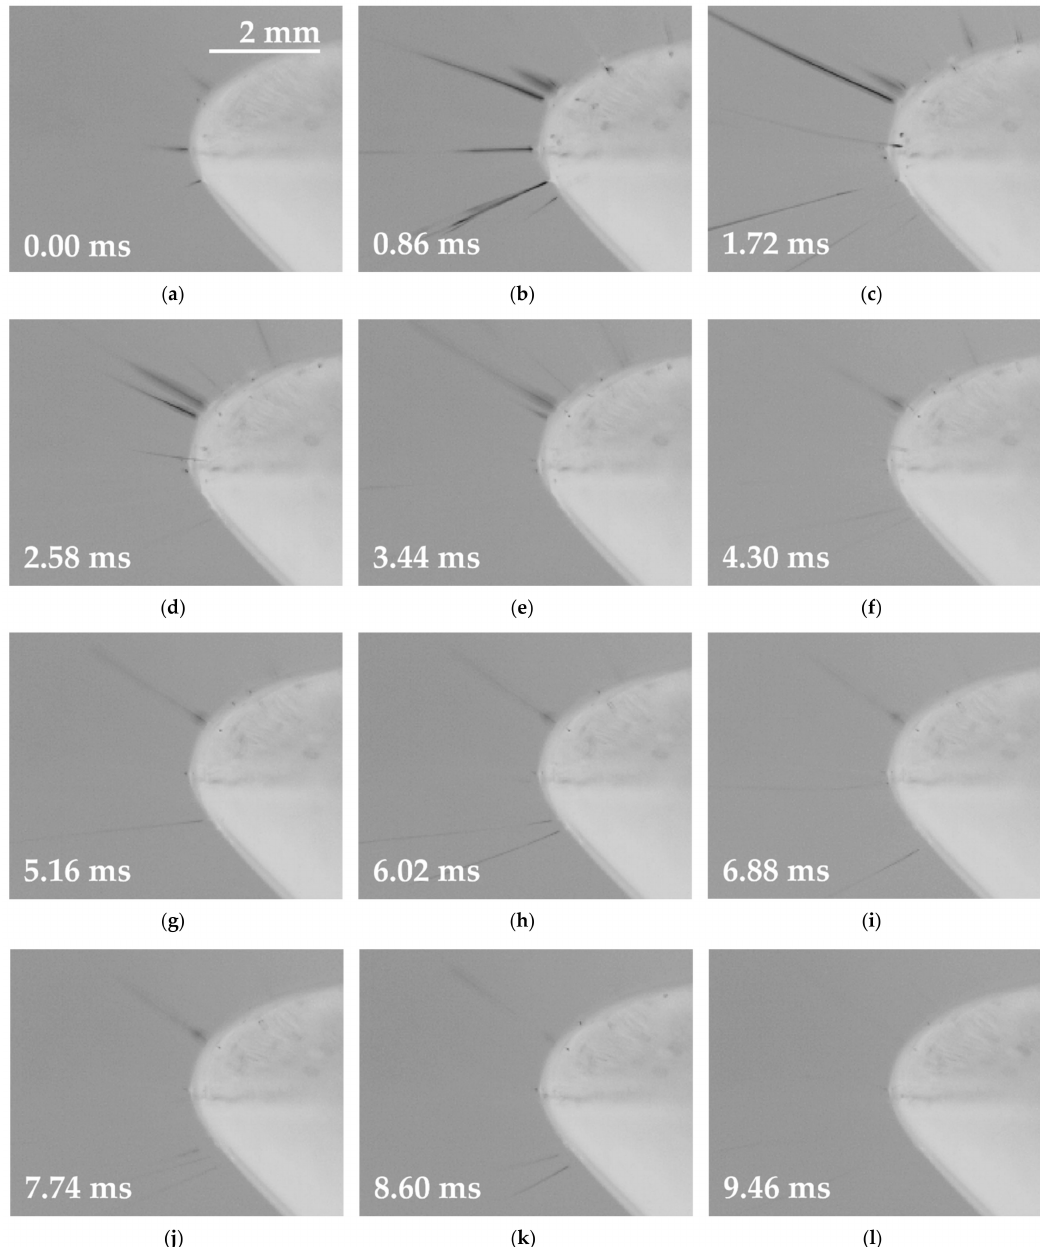
Figure 6. A frame sequence showing the accelerated electrospinning of the modified PA 6 solution driven by the step function. Upon traversing the zero line ( a ), the cones from the previous pulse were still visible; this was followed by the rapid offset of efficient electrospinning ( b , c ). A reduction in the efficiency of the process was visible ( d , e ), which led to a stable but less efficient process ( f – j ) for the rest of the pulse. The collapse of the weakening jets ( k ) led to an occasional state without the presence of any local instability ( l ), which lasted for the rest of the half-wave (around 0.54